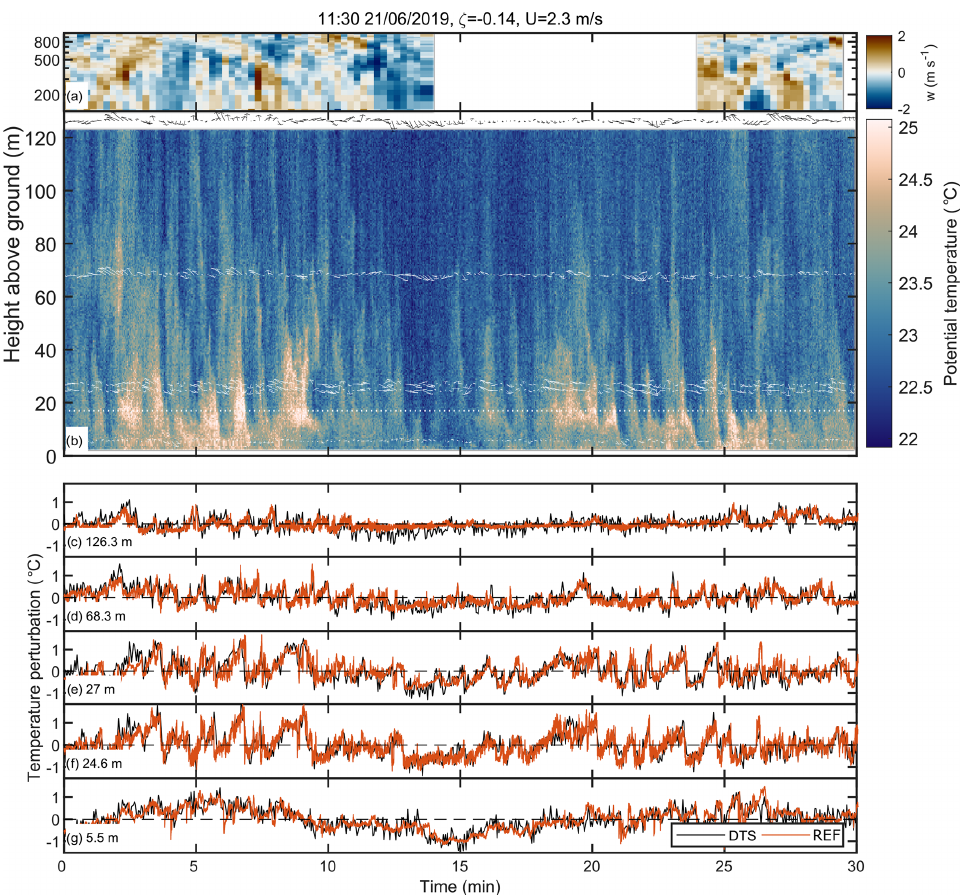
Figure 8. Example of simultaneous lidar, DTS and 3D sonic anemometer measurements during daytime convective conditions. (a) Lidar vertical wind velocity component (gap is due to non-vertical operation during scanning sequence). (b) Temperature profiles measured with the DTS system (colour) and wind speed fluctuations (arrows) measured with 3D sonic anemometers. For illustration purposes, the wind speed fluctuations were averaged over 10s, and the vertical wind component was multiplied by 10 prior to plotting. Length of the arrows denote the magnitude of the wind speed fluctuations, and direction is determined by the sign of vertical ( w (cid:48) ) and horizontal ( u (cid:48) ) wind speed fluctuations (up – w (cid:48) > 0; down – w (cid:48) < 0; left – u (cid:48) < 0; right – u (cid:48) > 0). (c–g) Temperature perturbations ( T − T ) measured with DTS and sonic anemometers at different heights on the mast. Local time (universal coordinated time – UTC + 2), the corresponding stability parameter ( ζ ) and mean wind speed ( U ) measured at 27m height are given in the figure title. Canopy height was approximately 17m and is highlighted with a white dotted line in panel (b) . For illustration purposes, the data gaps from cable holder locations were filled with linear interpolation prior to